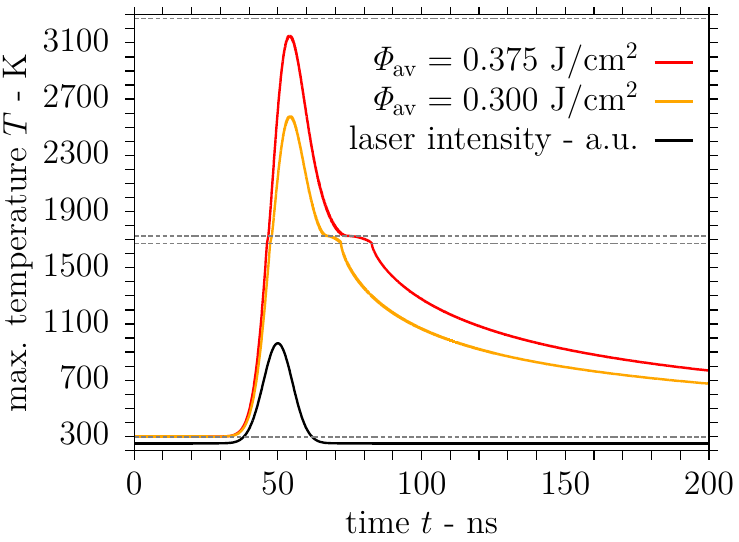
Figure 9. Maximum surface temperature during single pulse DLIP of stainless steel with Gaussian beams using the process parameters λ = 1053 nm, Λ = 7.2 µm, τ p = 12 ns and 2 Φ 0 = 0.532 J/cm 2 or 2 Φ 0 = 0.665 J/cm 2